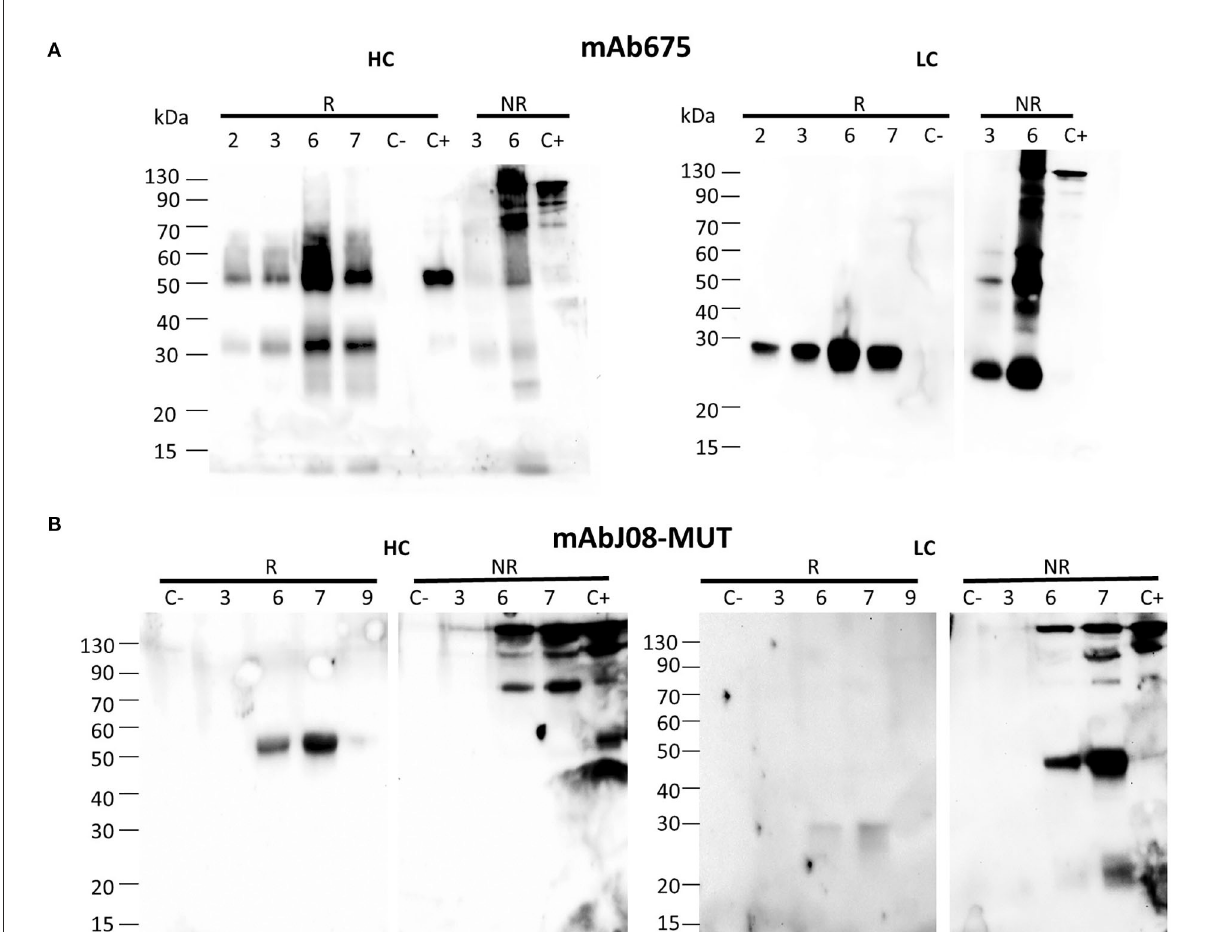
FIGURE1 Accumulation of anti-SARS-CoV-2 nAbs in agroinfiltrated FX-KO N. benthamiana plants. Western blot analysis of extracts of N. benthamiana plants syringe co-agroinfiltrated with A. tumefaciens strains harboring the HC and LC of either mAb675 (A) or mAbJ08-MUT (B) . Samples obtained from leaves (taken at 2, 3, 6, or 7 d.p.i.) were separated on reducing (R) or non-reducing (NR) 12% SDS-PAGE. Plant extracts were normalized for total soluble protein (TSP) content; 10 µ g of TSP was loaded for each sample. Extracts from plants infiltrated with only P19 silencing suppressor were used as negative control (C-). As positive control (C + ), 50 ng of purified human IgG1 mAbRTX was used. Detection was performed with an anti-human γ chain (HC) or anti-human κ chain (LC) HRP-conjugated